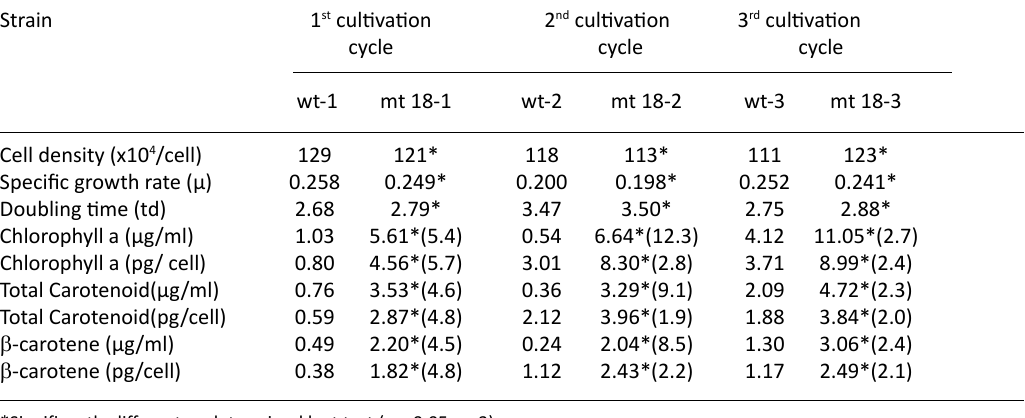
Table 2. Growth and pigment production of KU18 mutant at 12 th days of cultivation. The number in brackets of mutant KU18 represents the fold numbers compared to the wild type in modified Johnson’s medium